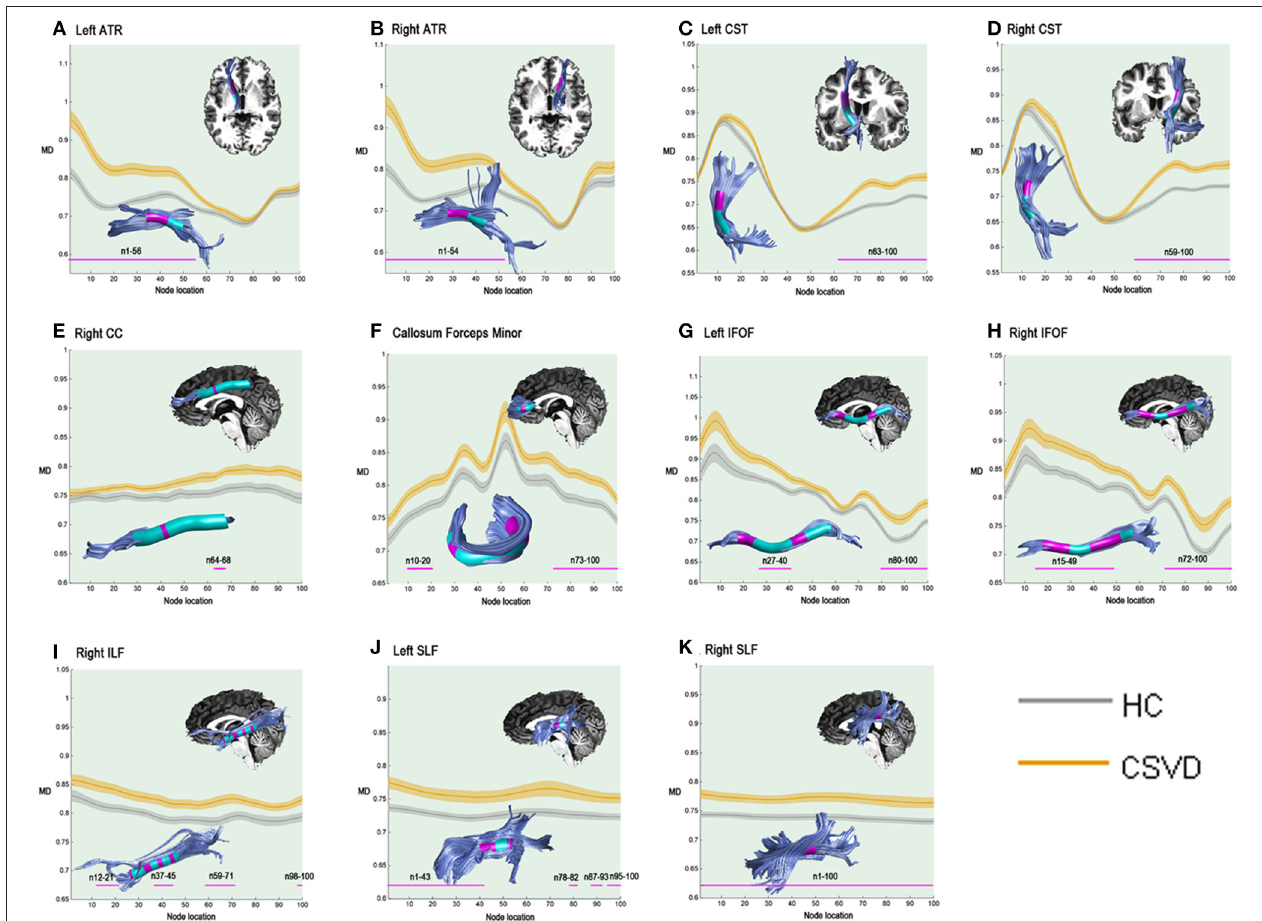
FIGURE 2 | Significantly damaged locations of fiber tracts between the HC and CSVD groups in the pointwise comparison of MD profiles (FWE correction, p < 0.05). The blue line indicates the HC group, the orange line indicates the CSVD group, the shadows represent the confidence interval, and the pink fiber segments are the position of the fiber segment that is different between the groups. The significantly increased MD values in CSVD group (FWE correction, p < 0.05) were located in (A) the anterior half of the left ATR (nodes 1–56); (B) the anterior half of the right ATR (nodes 1–54); (C) the superior portion of the left CST (nodes 63–100); (D) the superior portion of the right CST (nodes 59–100); (E) the posteromedial component of the right CC (nodes 64–68); (F) the frontal lobe portions of the callosum forceps minor (nodes 10–20 and nodes 73–100); (G) the anterior and intermediate portions of the left IFOF (nodes 27–40 and nodes 80–100); (H) the anterior and intermediate components of the right IFOF (nodes 15–49 and nodes 72–100); (I) the anterior, intermediate and posterior portions of the right ILF (nodes 12–21; nodes 37–45; nodes 59–71; and nodes 98–100); (J) the anterior and posterior portions of the left SLF (nodes 1–43; nodes 78–82; nodes 87–93; and nodes 95–100); and (K) the entire fiber bundle of the right SLF (nodes 1–100). HC, health control; CSVD, cerebral small vessel disease; MD, mean diffusivity; ATR, anterior thalamic radiation; CST, corticospinal tract; CC, cingulum cingulate; IFOF, inferior fronto-occipital fasciculus; ILF, inferior longitudinal fasciculus; SLF, superior longitudinal